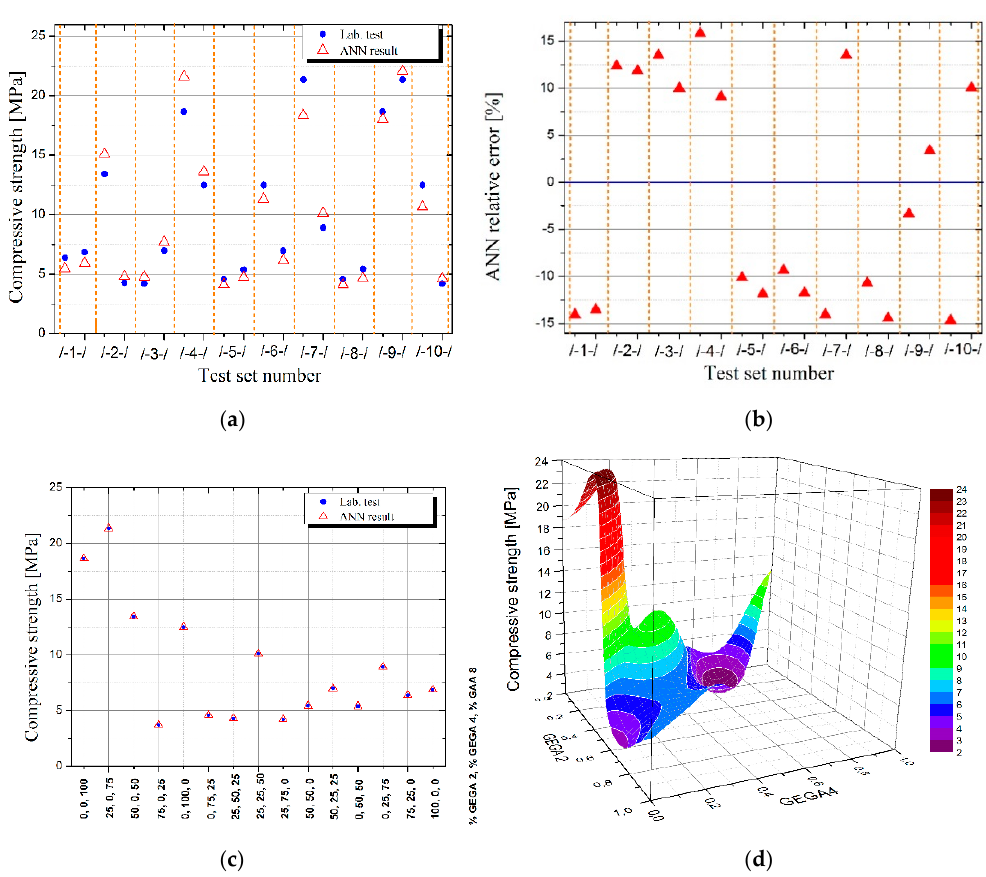
Figure 4. Illustration of the results, obtained by means of using ANN for compressive strength of LWC as a function of GEGA 2 mm and GEGA 4 mm shares in the specimen, ( a ) results generated by ANN for individual testing datasets ( b ) relative error of ANN for individual testing datasets ( c ) comparison of measurement results with values obtained by ANN for training database, ( d ) values of strength of LWC predicted by ANN for intermediate points between measurement data from the training dataset.